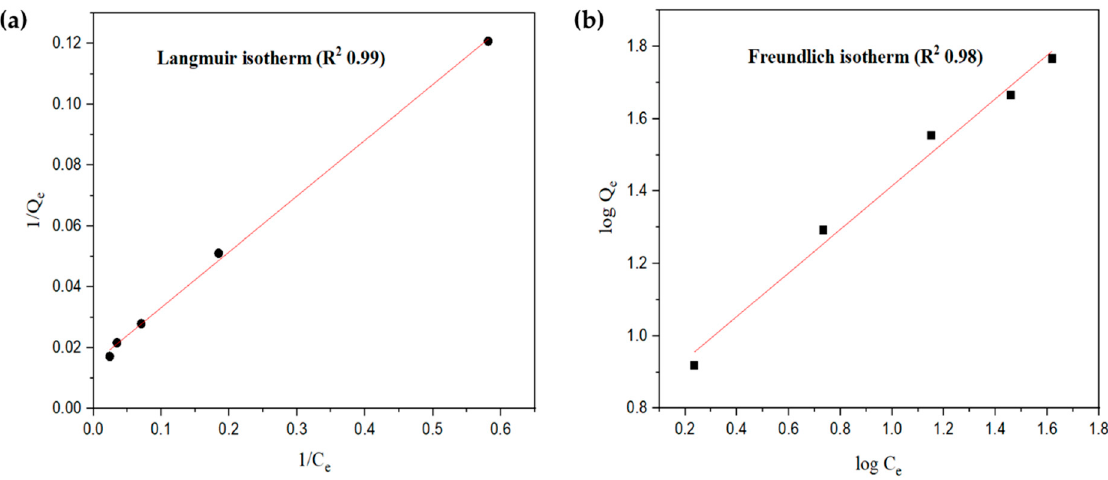
Figure 10. Isotherm models for Ni 2+ adsorption by PSDB; ( a ) Langmuir and ( b ) Freundlich isotherm models.